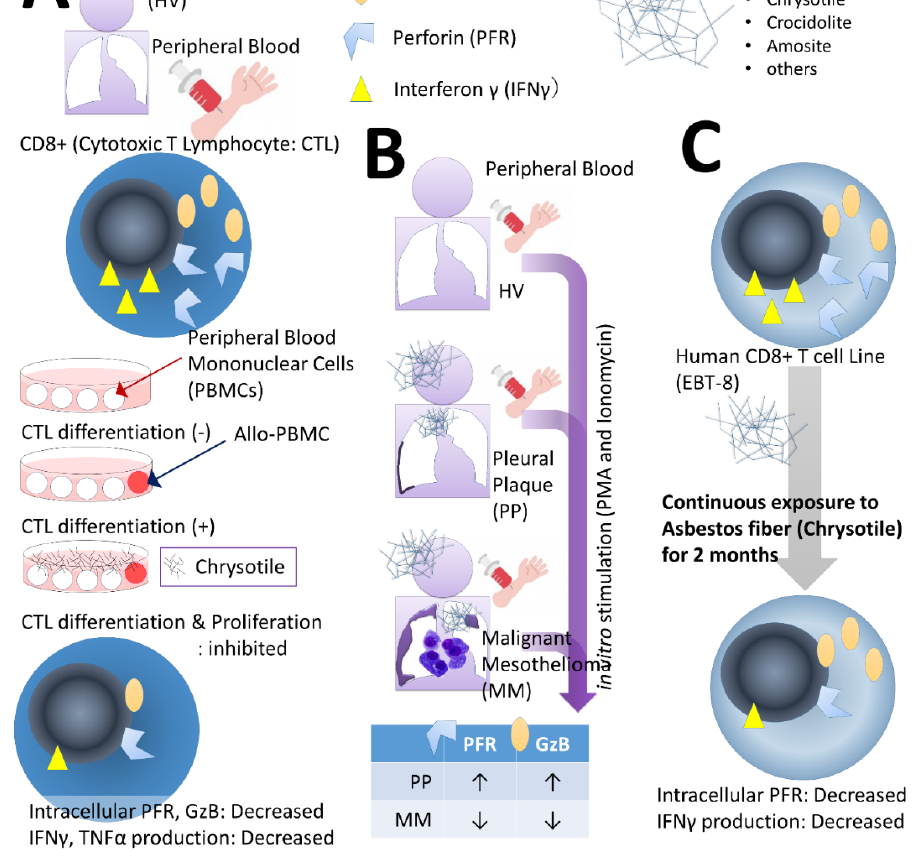
Figure 1. Observation of the effect of asbestos fibers on CD8+ cytotoxic T lymphocytes (CTLs). In the peripheral blood mononuclear cells (PBMCs) collected from ( A ) healthy volunteers (HVs), clonal expansion of CTLs was observed in the mixed lymphocyte reaction (MLR). When co-cultured with allogenic PBMCs, CD8+ cells differentiated into CTLs and proliferated, but when chrysotile and asbestos fibers were added, both differentiation and proliferation were suppressed. Furthermore, expression of granzyme B (GzB) and perforin (PFR), which execute the cell killing mechanism, and the production of interferon (IFN)- γ and tumor necrosis factor (TNF)- α, which are closely related cytokines, were also reduced. ( B ) With HV, CD8+ cells were isolated from the peripheral blood of patients with pleural plaque (PP) and malignant mesothelioma (MM), stimulated with phorbol 12-myristate 13-acetate (PMA) and ionomycin overnight, and expression levels of PFR and GzB in the chamber were observed. In the PP group, both were higher compared with HV and decreased in the MM group. ( C ) After the human CD8+ cell line ETV-8 was continuously exposed to chrysotile and asbestos fibers for 2 months, intracellular PFR decreased and IFN- γ production decreased.